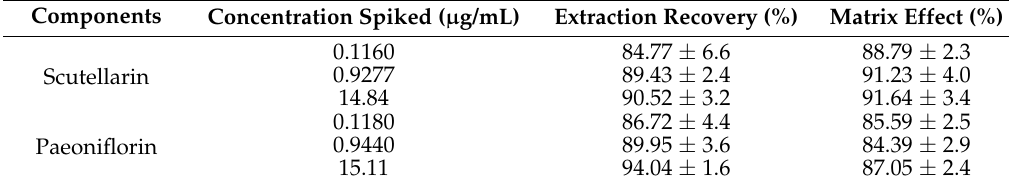
Table 2. Extraction recoveries and matrix effect of the two analytes in rat plasma (mean ± SD, n = 5). Components Concentration Spiked ( µ g/mL)